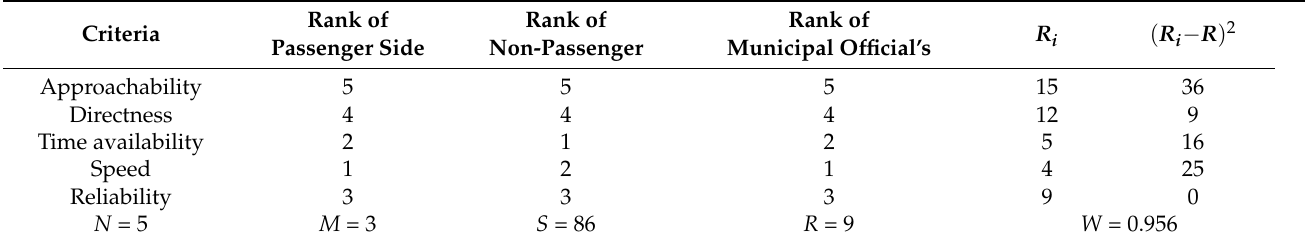
Table 5. Kendall’s coefficient of concordance ( W ) for level 1.